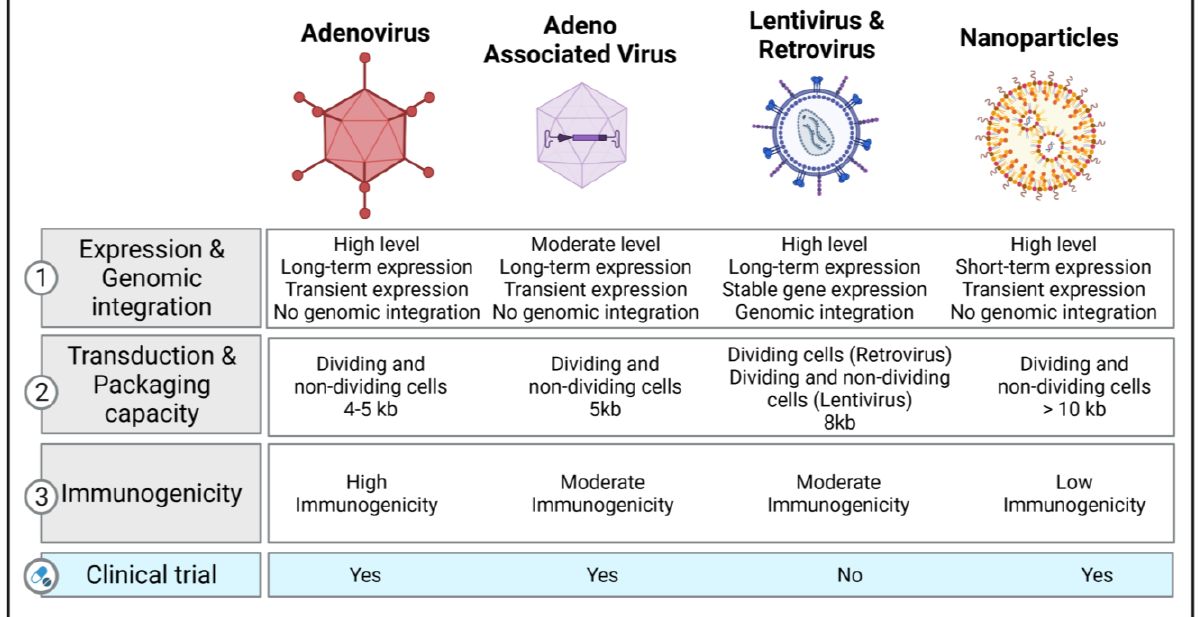
Figure 2. Vector platforms and their characteristics available for gene transfer. The table lists the different types of vectors (adenovirus, adeno-associated virus, lentivirus, retrovirus, and nanopar- ticles) used in clinical and preclinical studies for treating respiratory diseases and refers to specific information related to expression levels, genome integration, transduction, packaging capacity, im- munogenicity, and their use in clinical trials. Created with BioRender.com (accessed on 3 March 2022).